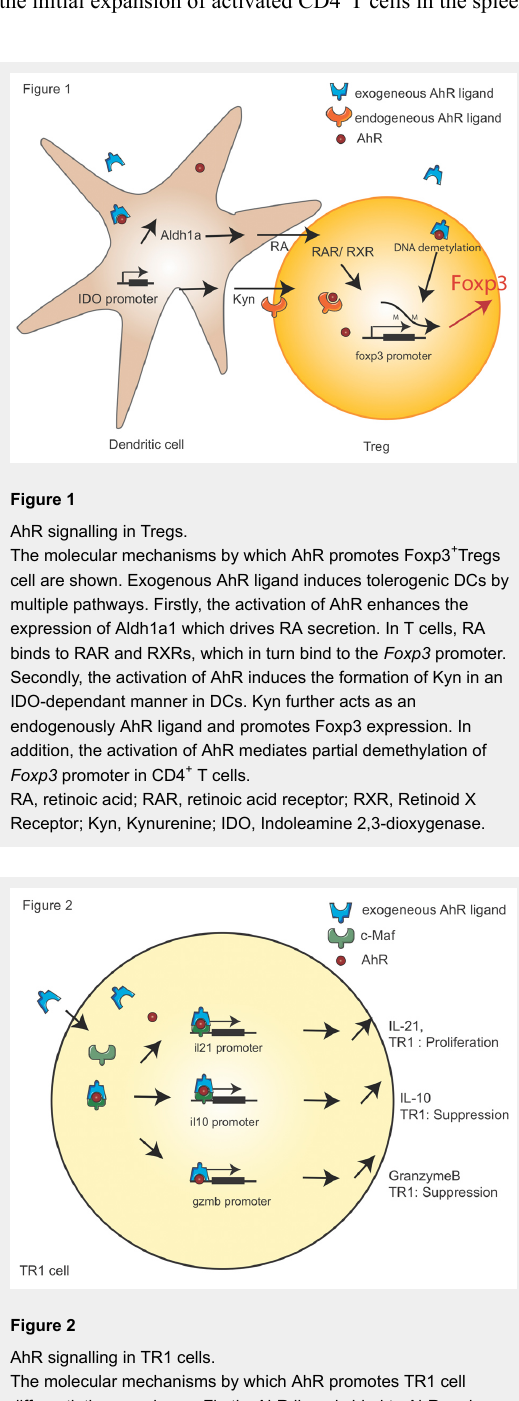
AhR signalling in TR1 cells. The molecular mechanisms by which AhR promotes TR1 cell differentiation are shown. Firstly, AhR ligands bind to AhR and transactivates il21 promoter with c-Maf that promotes TR1 cell proliferation. Secondly, the same complex of AhR and c-Maf transactivates il10 promoter and mediates TR1 cell suppressive function. Thirdly, AhR drives the transactivation of Gzmb promoter that promotes granzyme B expression, which contributes to the suppressive activity of TR1